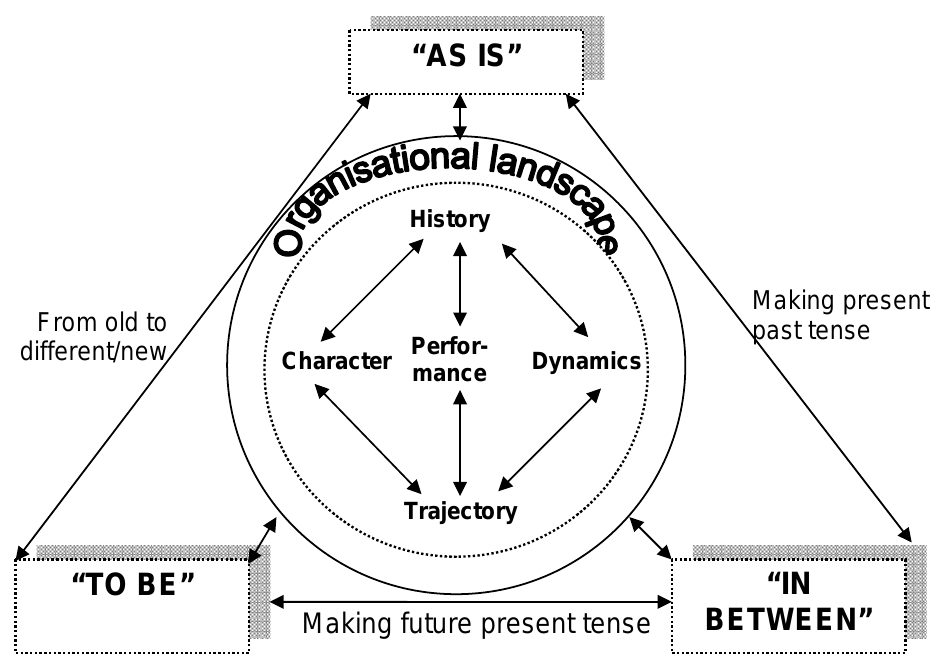
Figure 4: Strategising as simultaneously juggling three tenses and states relative to the organisational